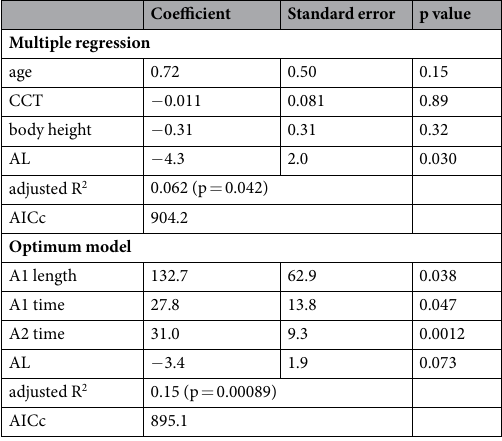
Table 4. Linear model results to explain cpRNFL peak angle. cpRNFL: circumpapillary retinal nerve fiber layer, CCT: central corneal thickness, AL: axial length, AICc: corrected Akaike information